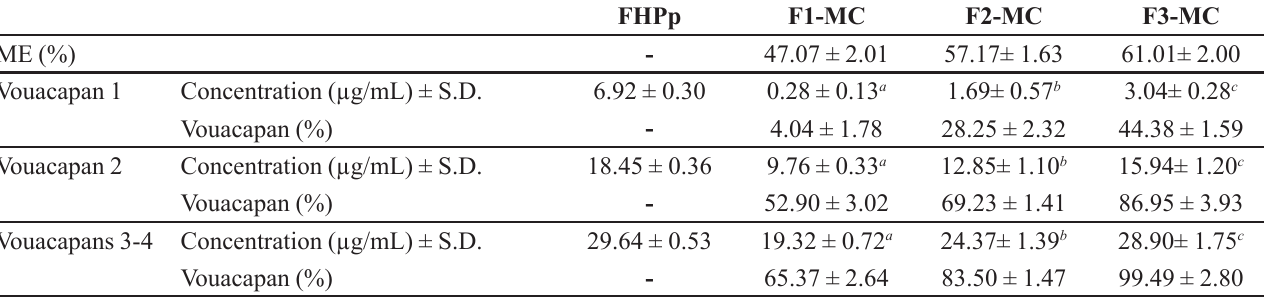
TABLE I - Microencapsulation efficiency of FHPp (ME%) and content of vouacapans microencapsulated (Vouacapan%) obtained by GC-MS-SIM